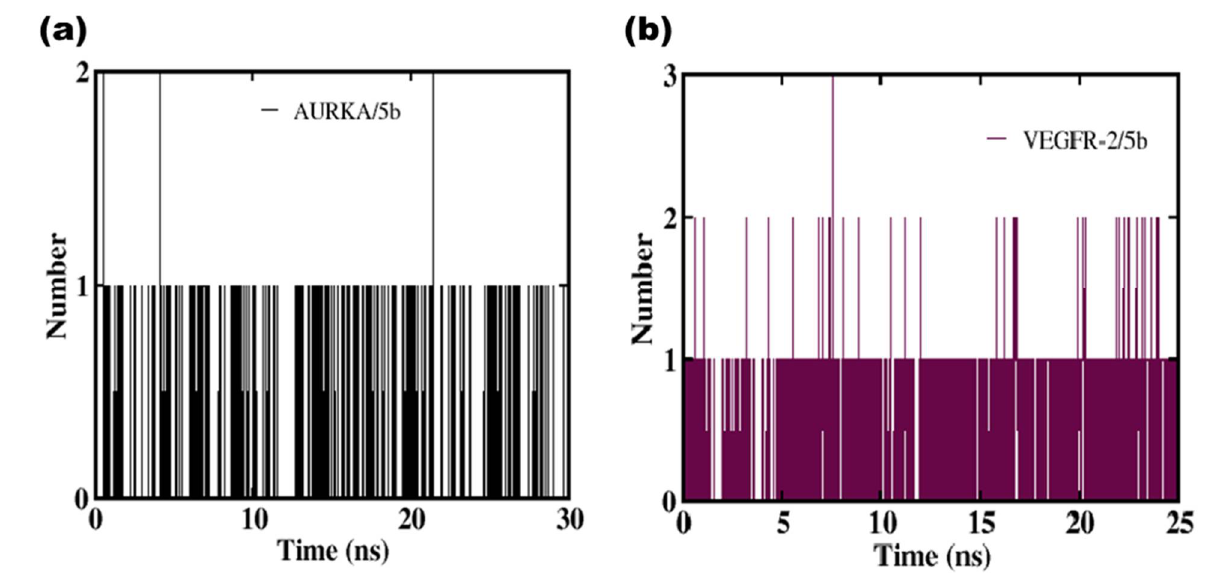
Figure 3. Average number of hydrogen bonds formed during simulation. The plot represents the complex of 5b with ( a ) AURKA and ( b ) VEGFR-2.